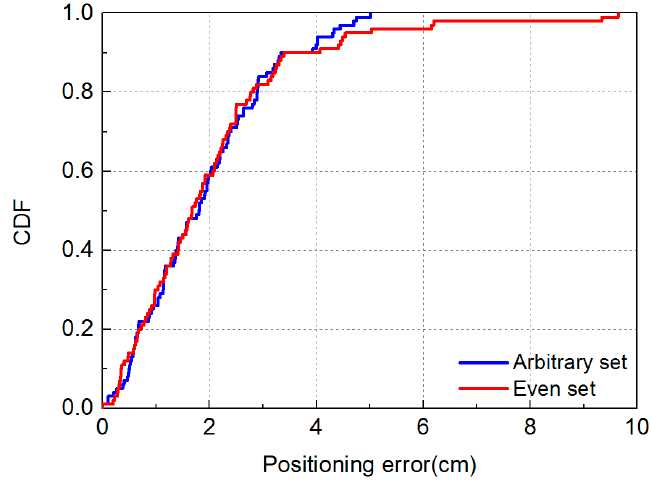
Figure 17. Cumulative distribution of positioning error for the arbitrary training data set and even training data set.